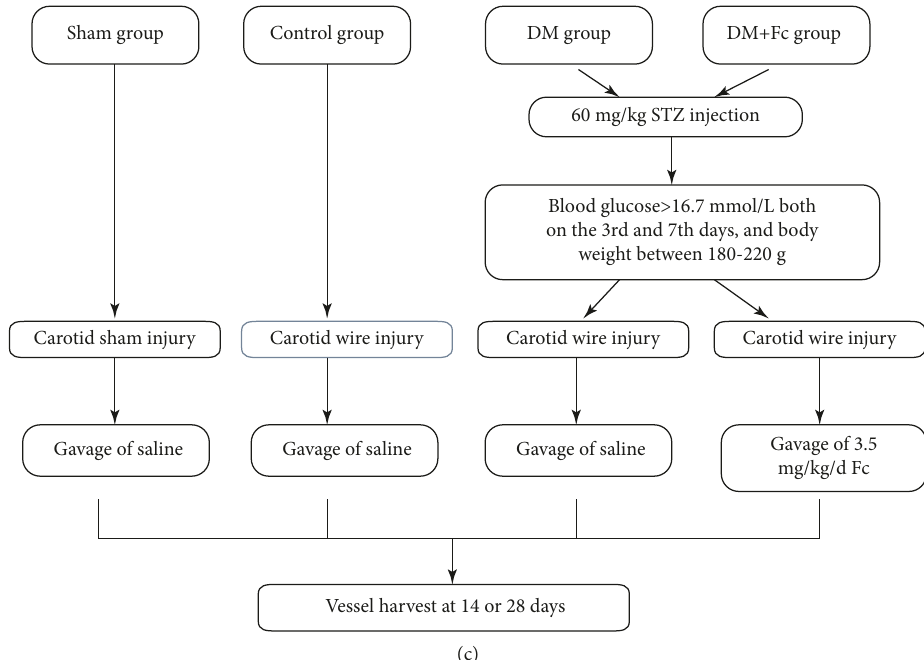
Figure 1: (a) Molecular structure of notoginsenoside Fc (Fc). (b) Blood glucose levels in the di ff erent rat groups at days 14 and 28. DM represents diabetes mellitus. (c) A schematic diagram illustrating the experimental animal groups and di ff erent treatments. STZ represents